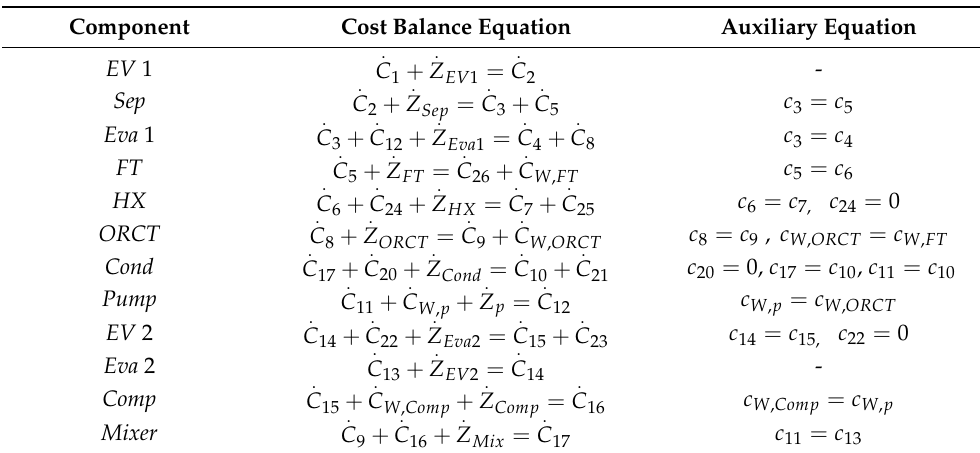
Table 4. Cost balance and auxiliary